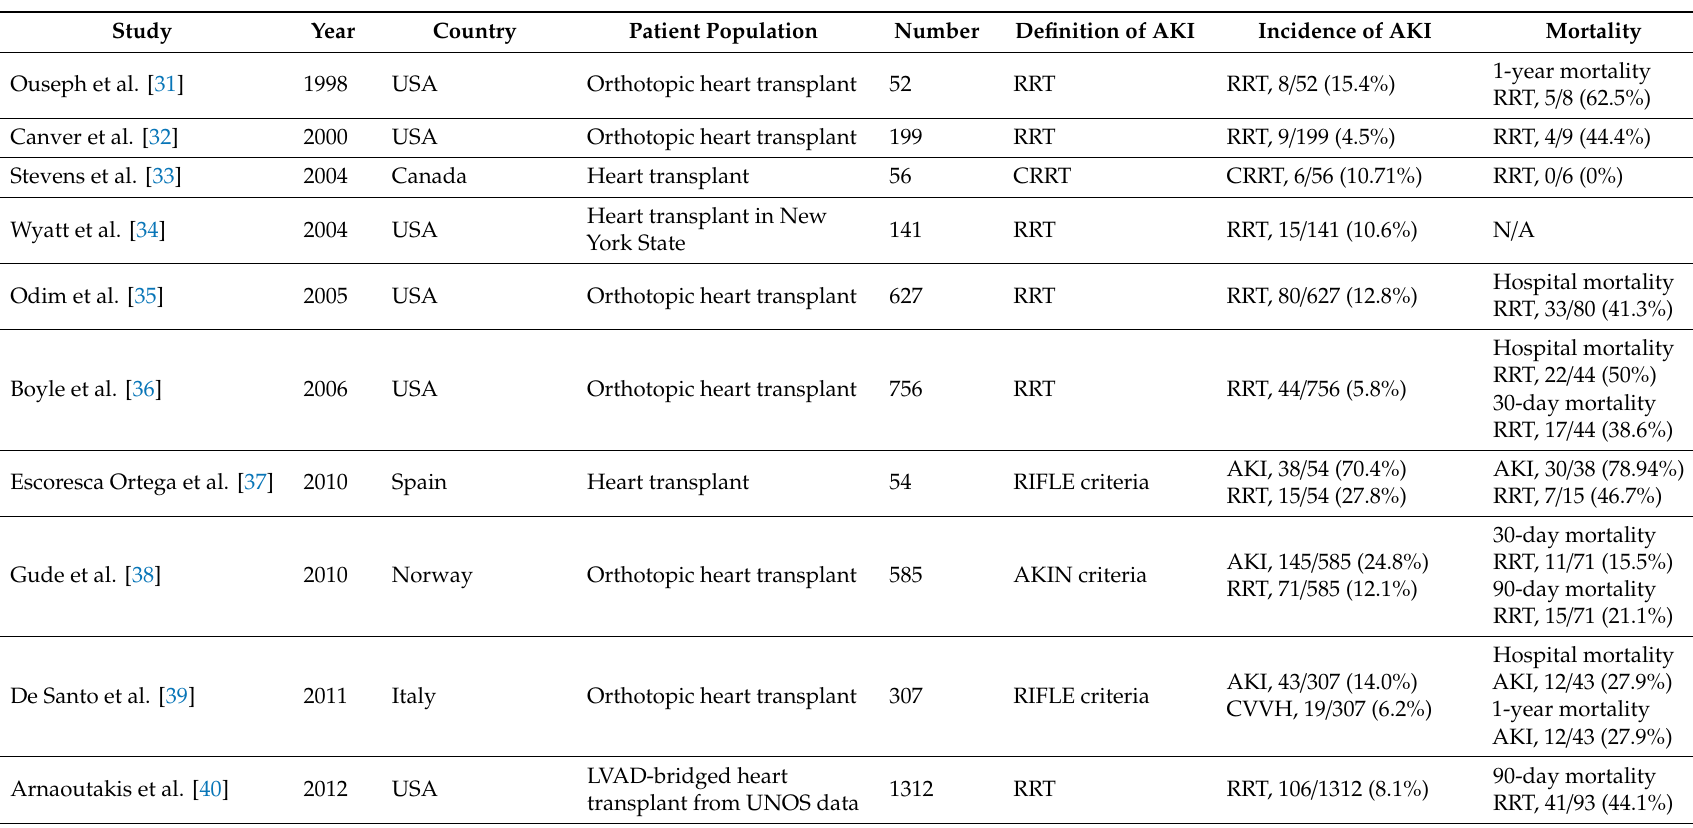
Table 1. Included studies in this systematic review of AKI incidence and mortality in patients undergoing cardiac transplantation. [8,18–20,31–35]. Study Year Country Patient Population Number Definition of AKI Incidence of AKI